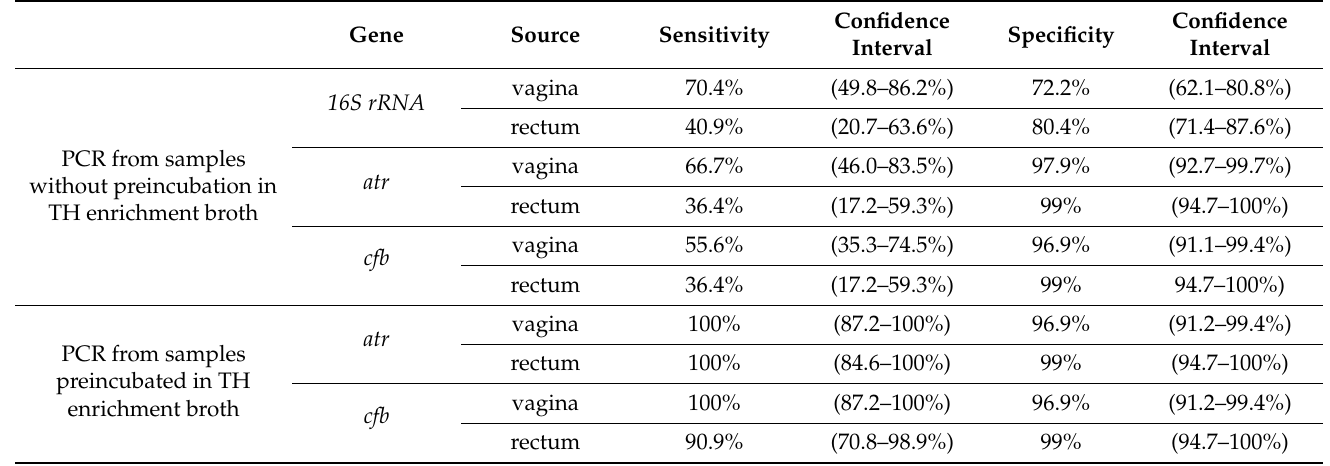
Table 2. The sensitivity and specificity of the results for tested primer pairs ( 16S rRNA and atr – conventional PCR and cfb –real-time PCR) in accordance with culture as a reference method.